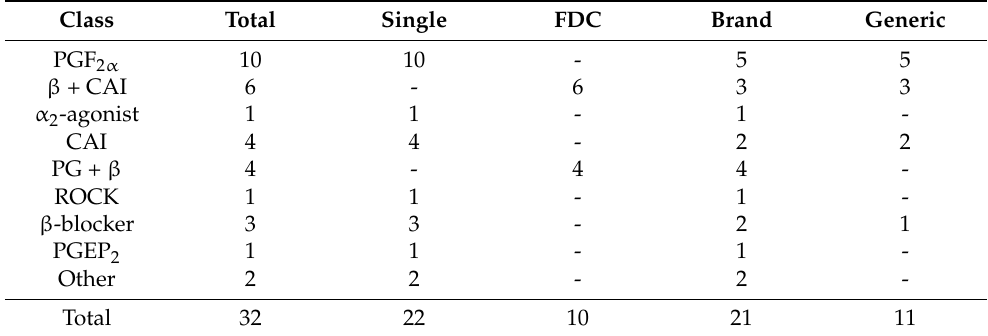
Table 1. Demographics of topical anti-glaucoma medications included in this